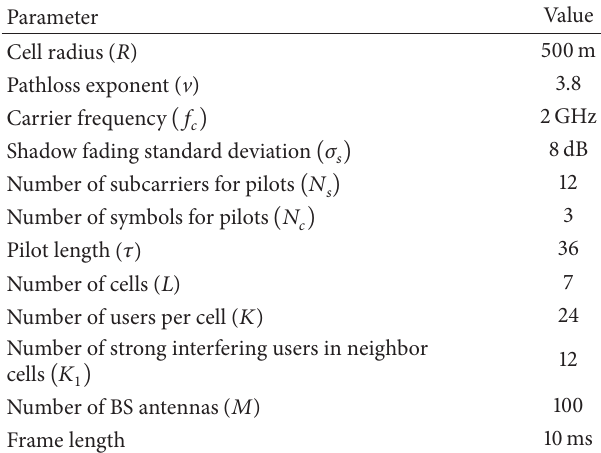
Table 1: Simulation